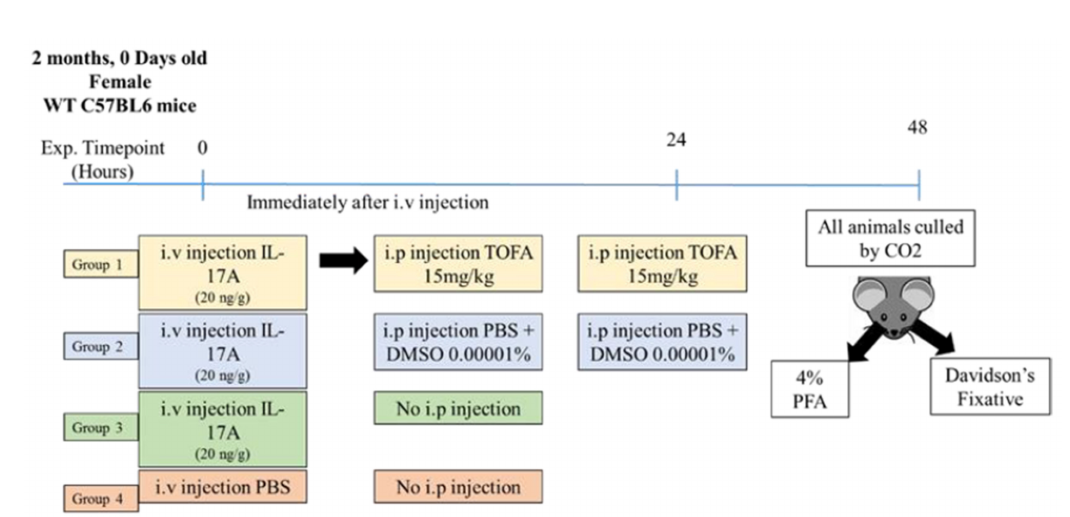
Figure 1. Study design: effect of Tofacitinib Citrate on IL-17A-mediated BRB leakage in WT mice.